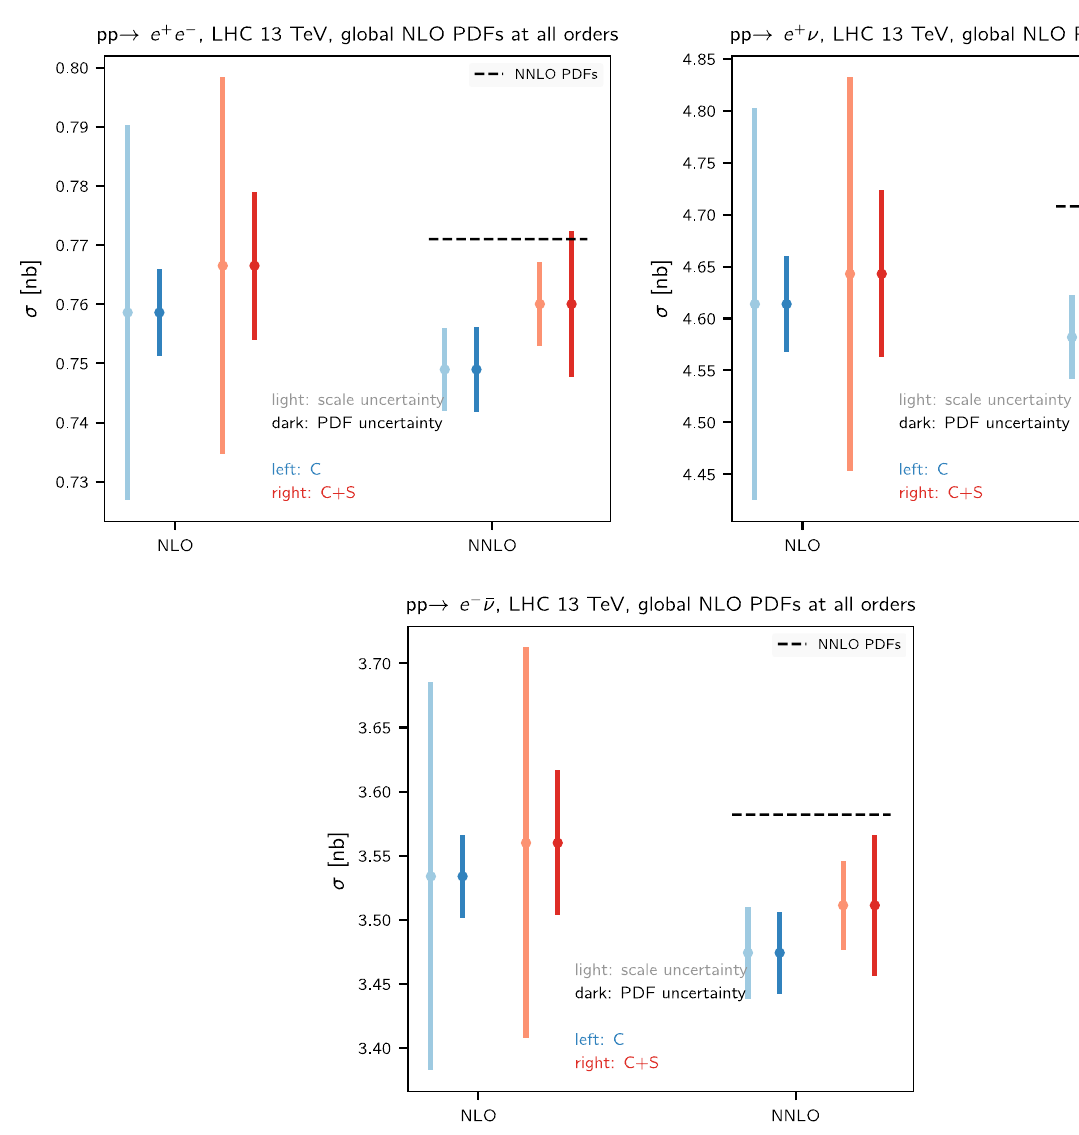
Fig. 23 Same as Fig. 21 for W ± and Z gauge boson production at